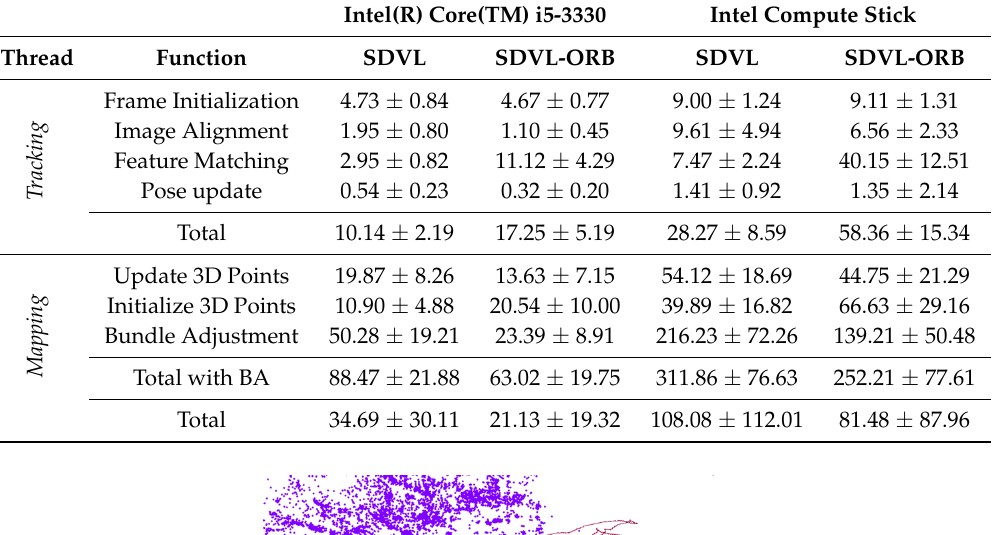
Table 2. Execution time (in ms per frame) itemized in sequence Machine Hall 01 .